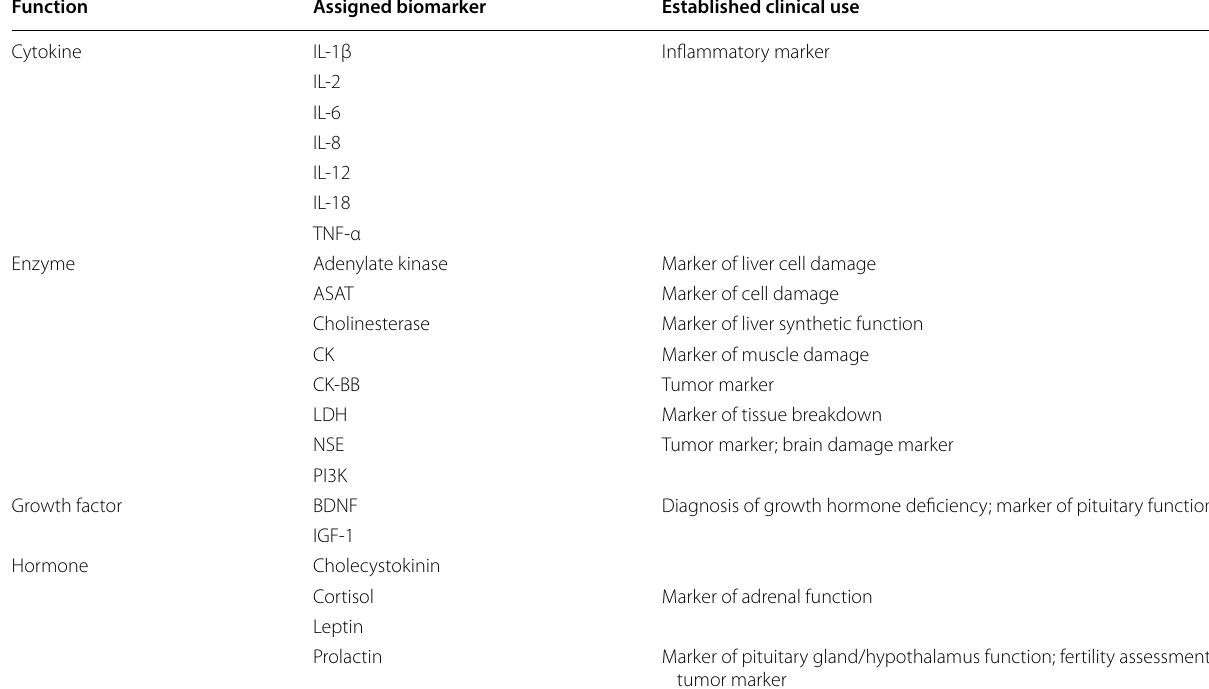
Table 2 Grouping of suggested biomarkers of delirium according to their main